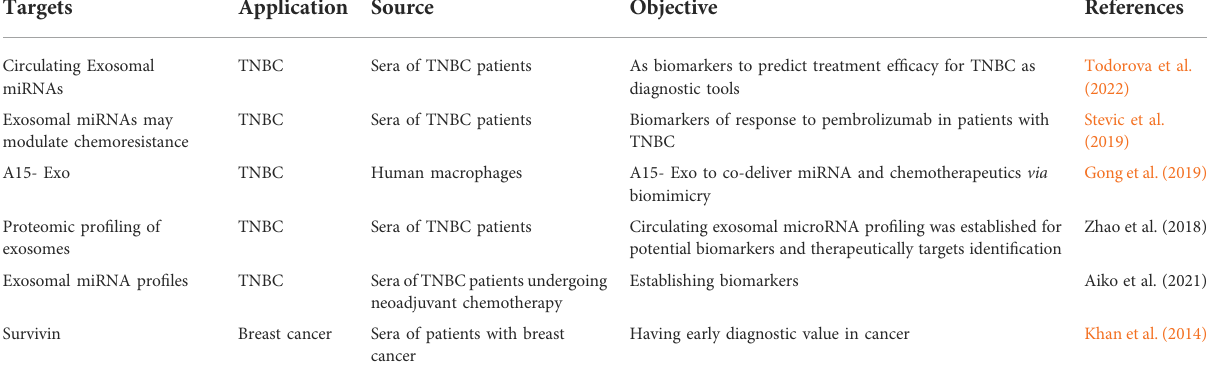
TABLE 2 Clinical application of exosomes in